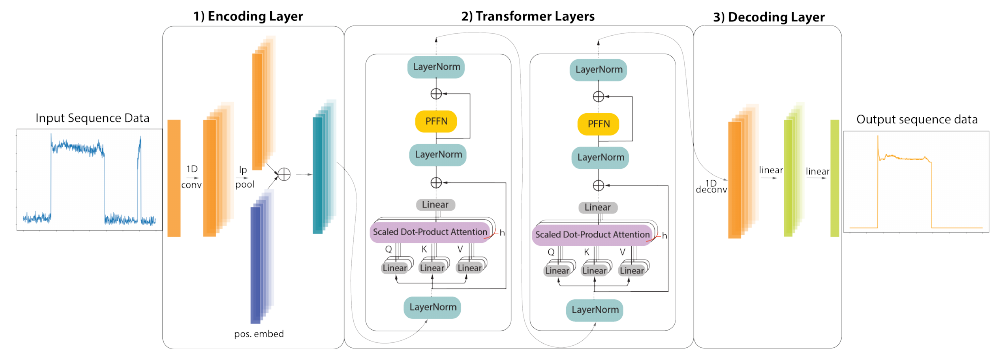
Figure 2. Proposed model architecture for ELECTRIcity’s generator and discriminator models. The architecture consists of 3 parts: (1) Encoding layer, which performs feature extraction from the input signal, (2) Transformer layers, which assign importance weights to the extracted features and (3) Decoding layer, which generates the desired output